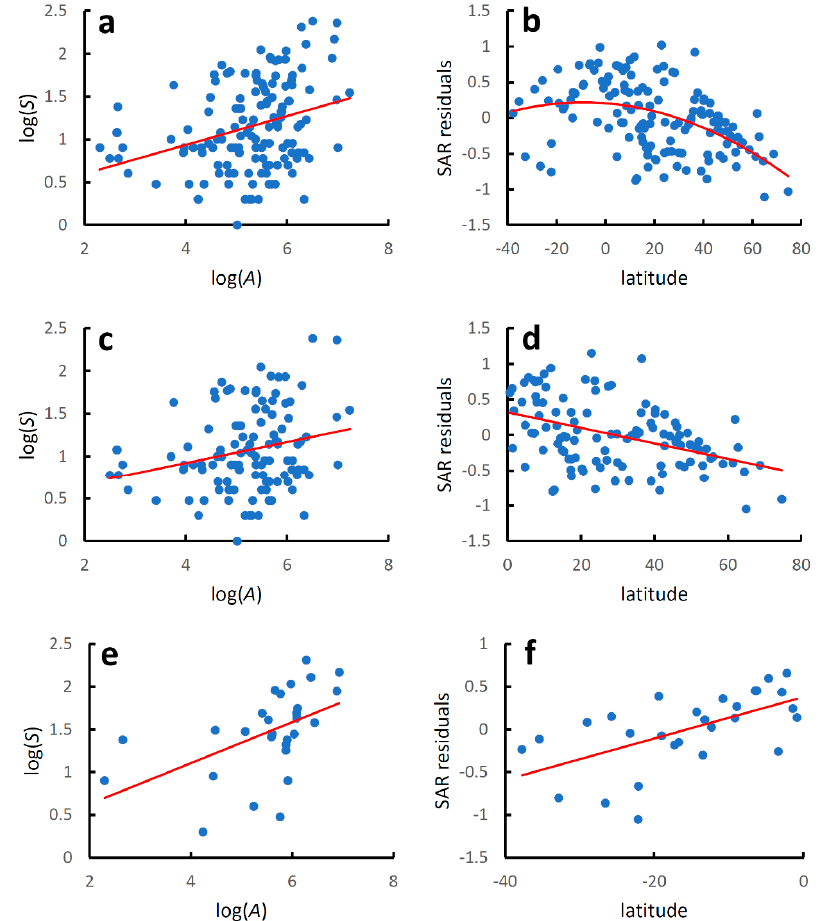
Figure 1. Earwig species–area relationships and latitudinal diversity gradients for world mainland and island countries. Species–area relationships were modelled using the linearized version of the power function: log( S ) = z log( A ) + log( c ), where S is the recorded species richness at country level, A is country area (km 2 ), and z and c are estimated parameters. Latitudinal gradients were modelled with regressing residuals from the species–area relationships (SAR residuals) against country latitude with a second-order polynomial regression for the whole dataset and with linear regressions for the two hemispheres separately. ( a ) Global species–area relationship; ( b ) global latitudinal gradient; ( c ) species–area relationship for the Northern Hemisphere; ( d ) latitudinal gradient for the Northern Hemisphere; ( e ) species–area relationship for the Southern Hemisphere; ( f ) latitudinal gradient for the Southern Hemisphere. Regression equations are given in Table 1.